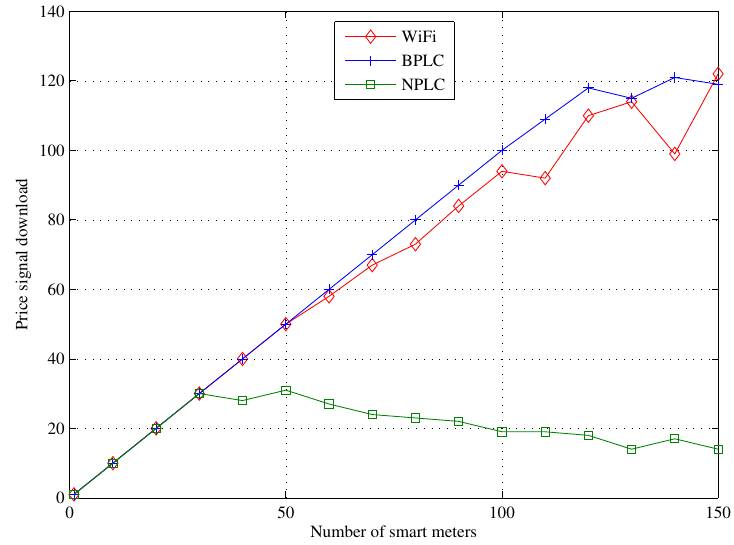
Figure 6. Successful peak price downloads versus number of smart